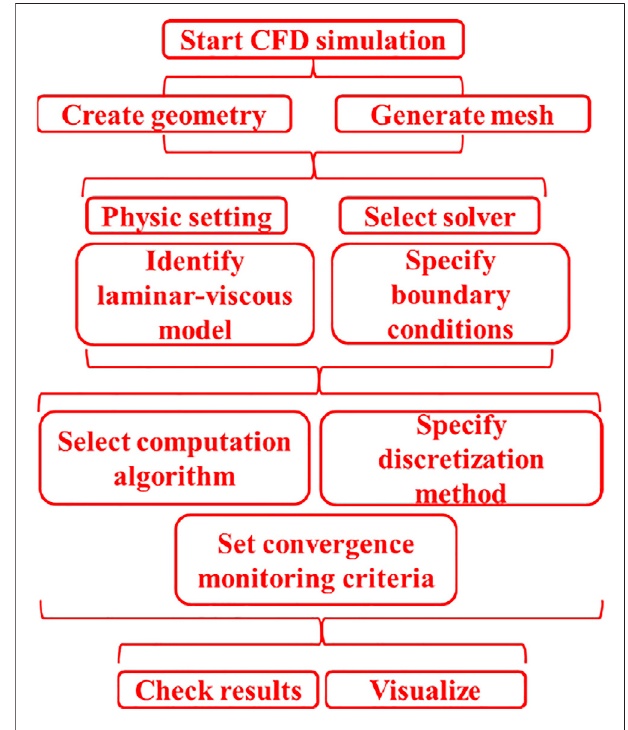
FIGURE 3 | Flow chart of CFD numerical